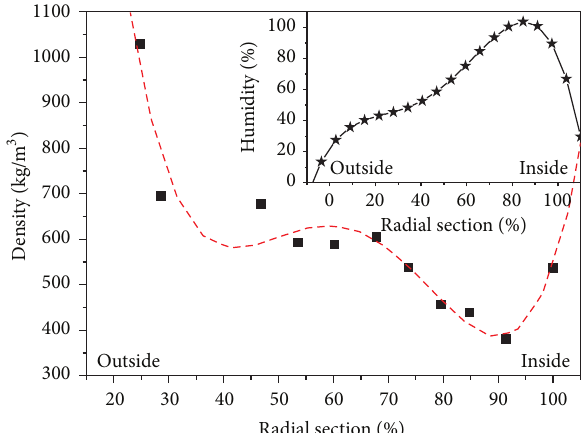
Figure3:DensityandhumiditycontentoftheGAKVBasafunction of radial section percentage of the